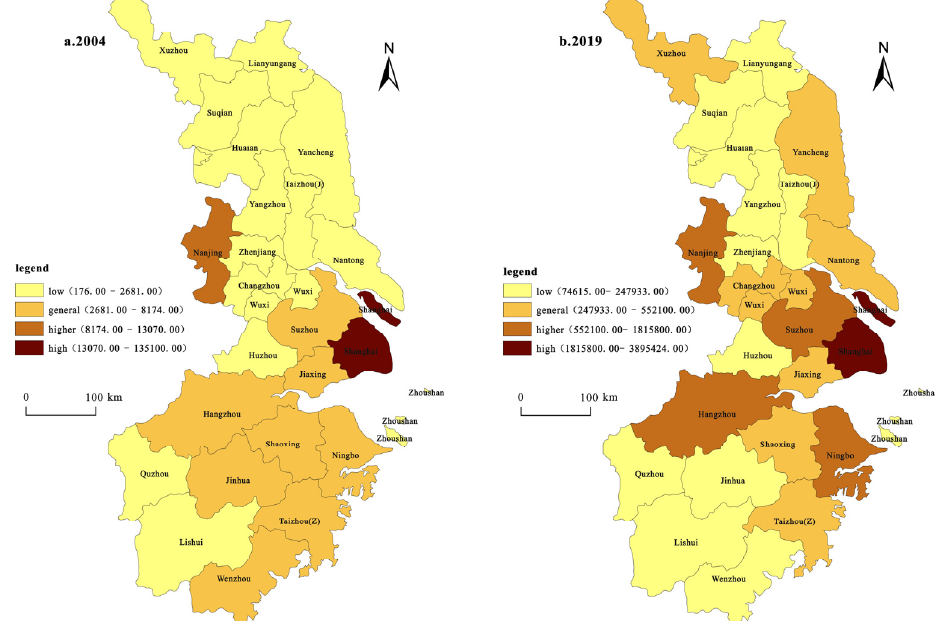
Figure 2. Spatial pattern change based on innovation input.